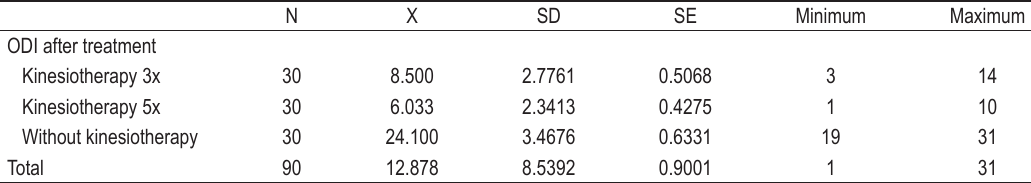
TABLE 4. Average values of oswestry disability index after treatment